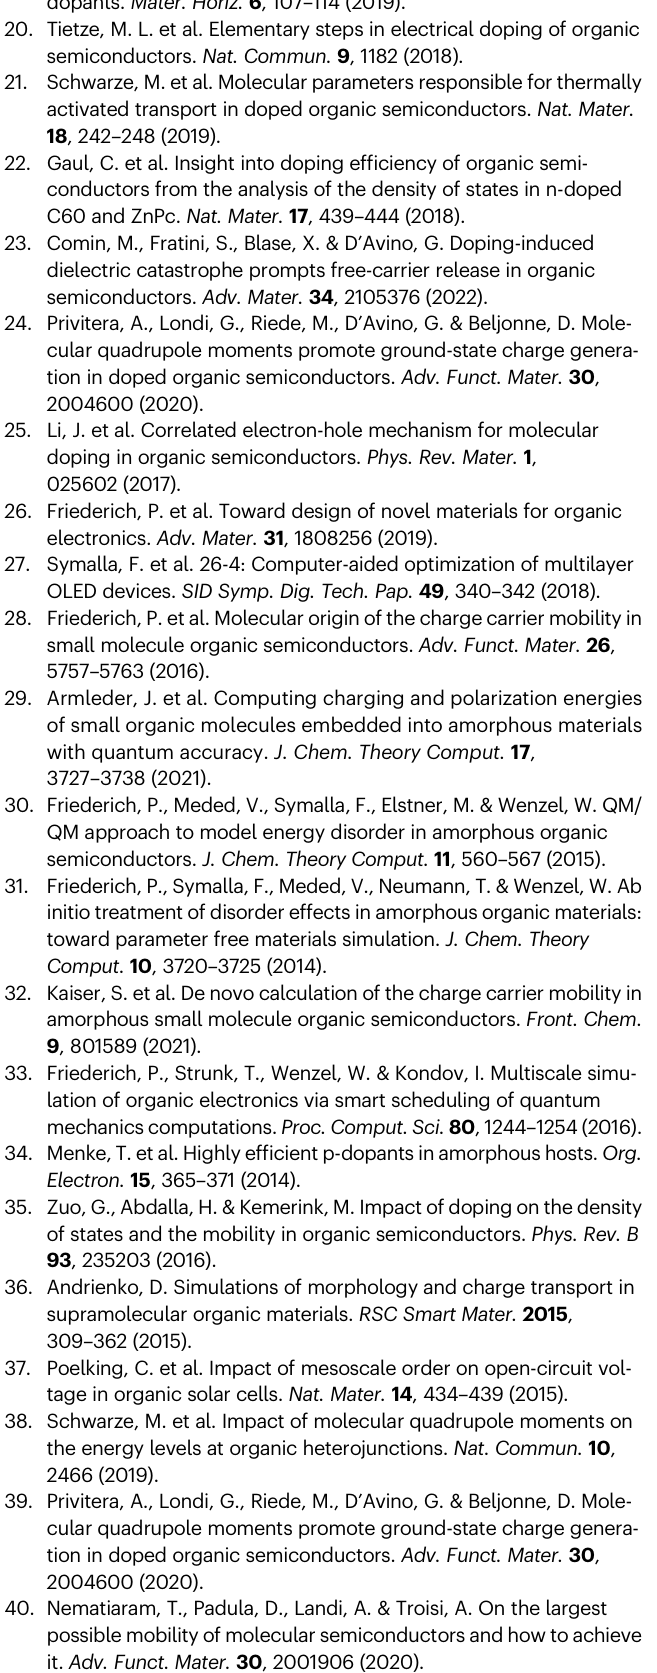
Fig. 3b and 4a show the mean and standard error of the mean,